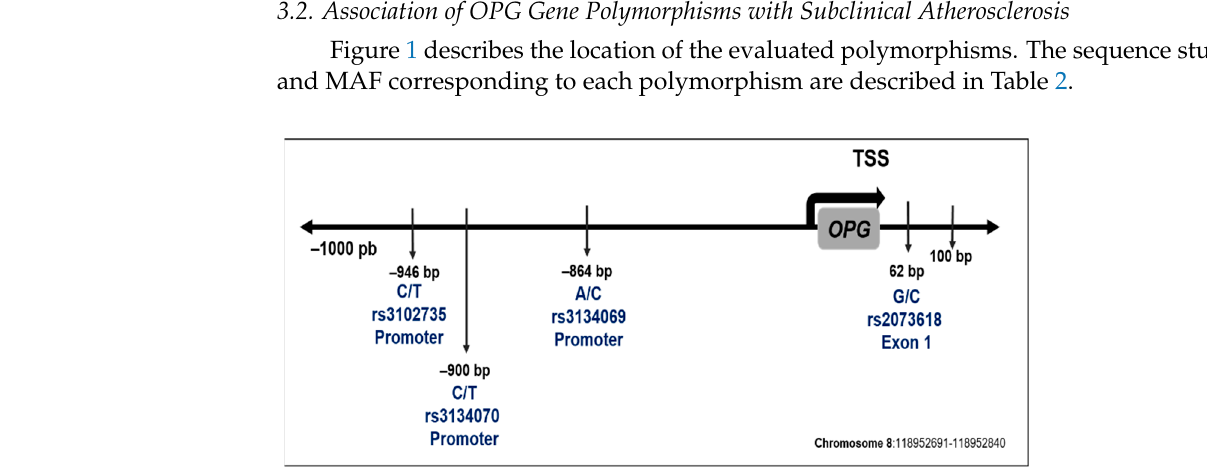
Figure 1. Location in the OPG gene sequence of selected polymorphisms. The position is with re- spect to the transcription start site (TSS). to the transcription start site (TSS). Table 2. Description of analyzed sequence of polymorphisms studied. Table 2. Description of analyzed sequence of polymorphisms